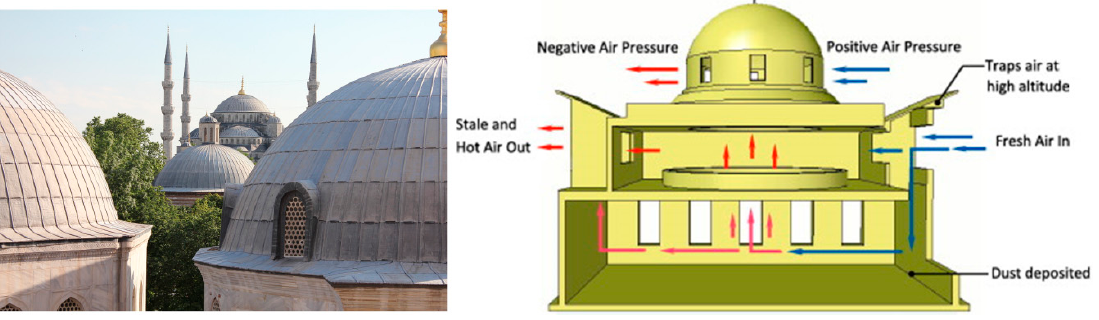
Figure 1. Traditional dome roof building [9,10].